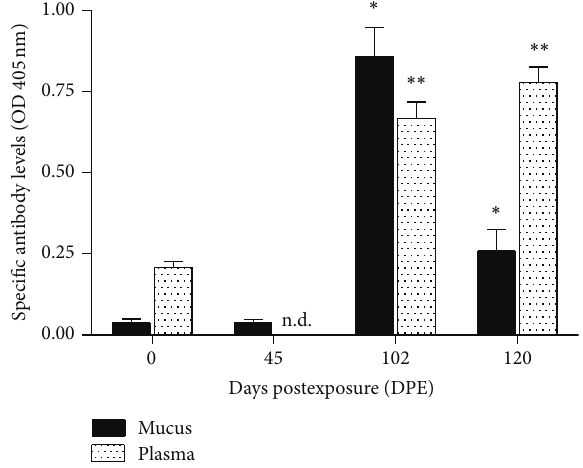
Figure 3: Effects of continuous exposure on specific antibody levels in tilapia mucus and plasma at 45, 102, and 120 days postexposure (DPE) and unexposed fish (0DPE) as determined by ELISA and represented by optical density (405 nm). Mucus and plasma samples were diluted 1: 3 and 1:2000 in PBS, respectively. Vertical bars indicate mean ± SEM. ∗ Significantly different from antibody levels in mucus of 0 DPE and 45 DPE groups at 𝑃 < 0.05 ; ∗∗ significantly different from antibody levels in plasma of 0 DPE groups at 𝑃 < 0.05 (one-way ANOVA and Student’s 𝑡 test). Blood samples were not collected at